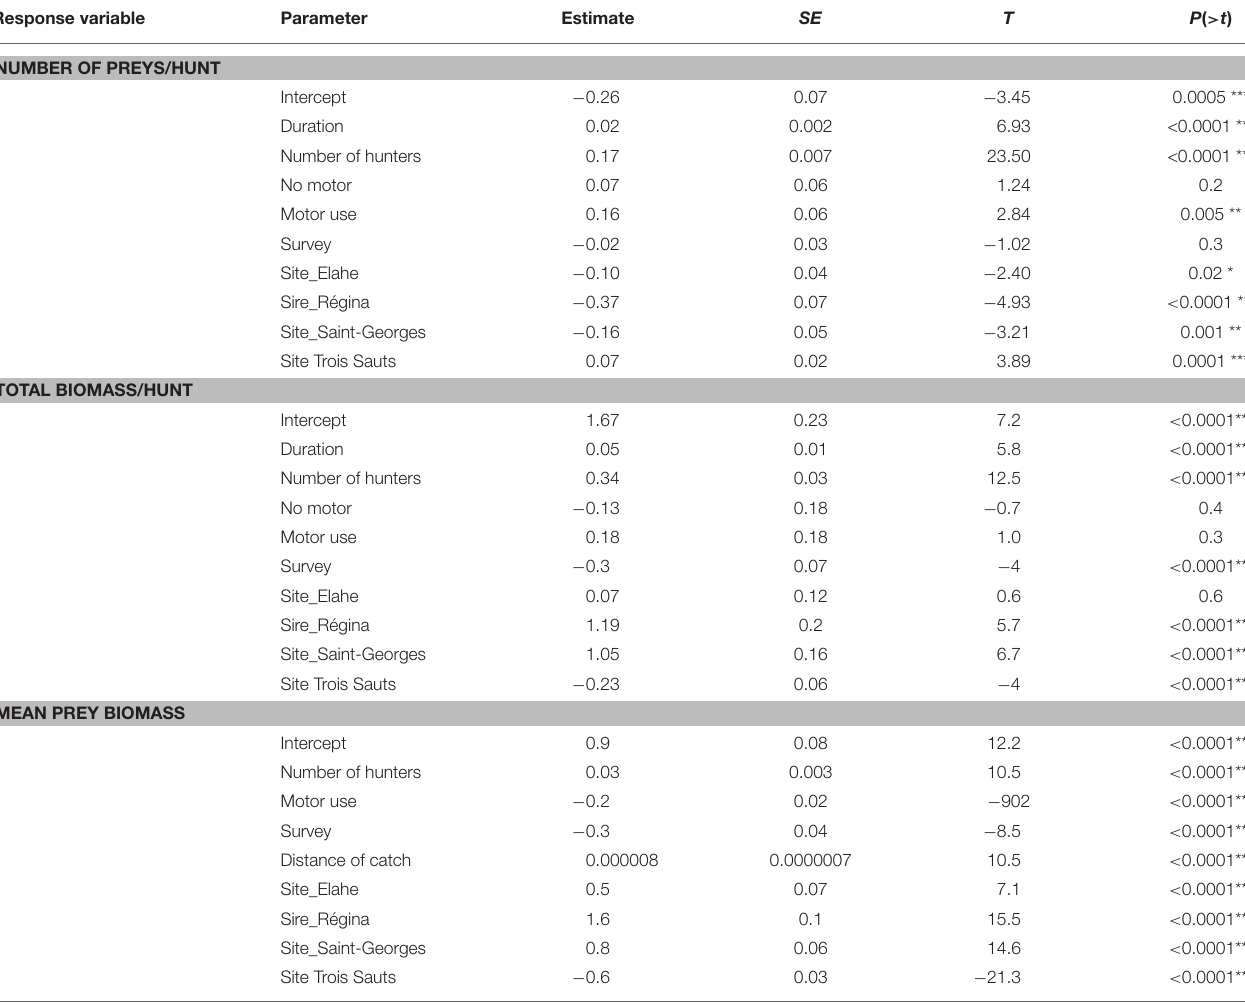
TABLE 3 | Variables explaining the variation of the hunting returns, in terms of (i) number of preys by hunt (quasipoisson regression, N = 3,192, Dispersion parameter taken to be 0.2899811, GOF test on residuals > 0.5) (ii) total biomass by hunt (gaussian regression, N = 2,889, adjusted R-squared: 0.18, p -value: < 2.2e-16) (iii) mean biomass of individual preys, N = 16,328, adjusted R-squared = 0.21, p < 0.0001). Response